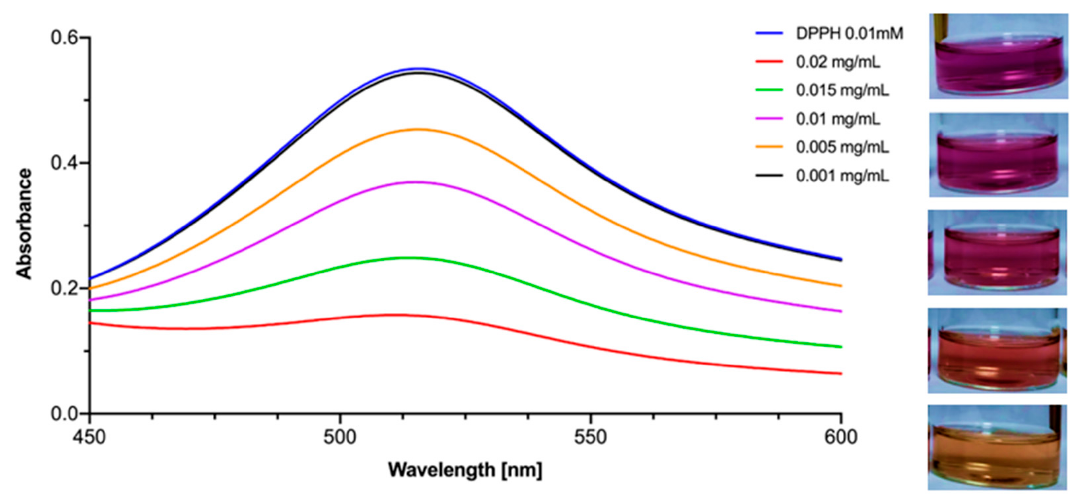
Figure 7. Absorbance of DPPH during DPPH assay of TiO 2 -GA depending on the concentration of the latter and photographs of the DPPH solutions with the addition of different concentrations of TiO 2 -GA suspensions. Table 5. IC 50 values of the tested samples determined in the DPPH test. Sample (Compound/Material)